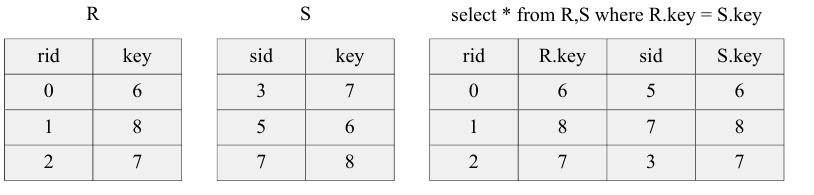
Figure 1. An example of an